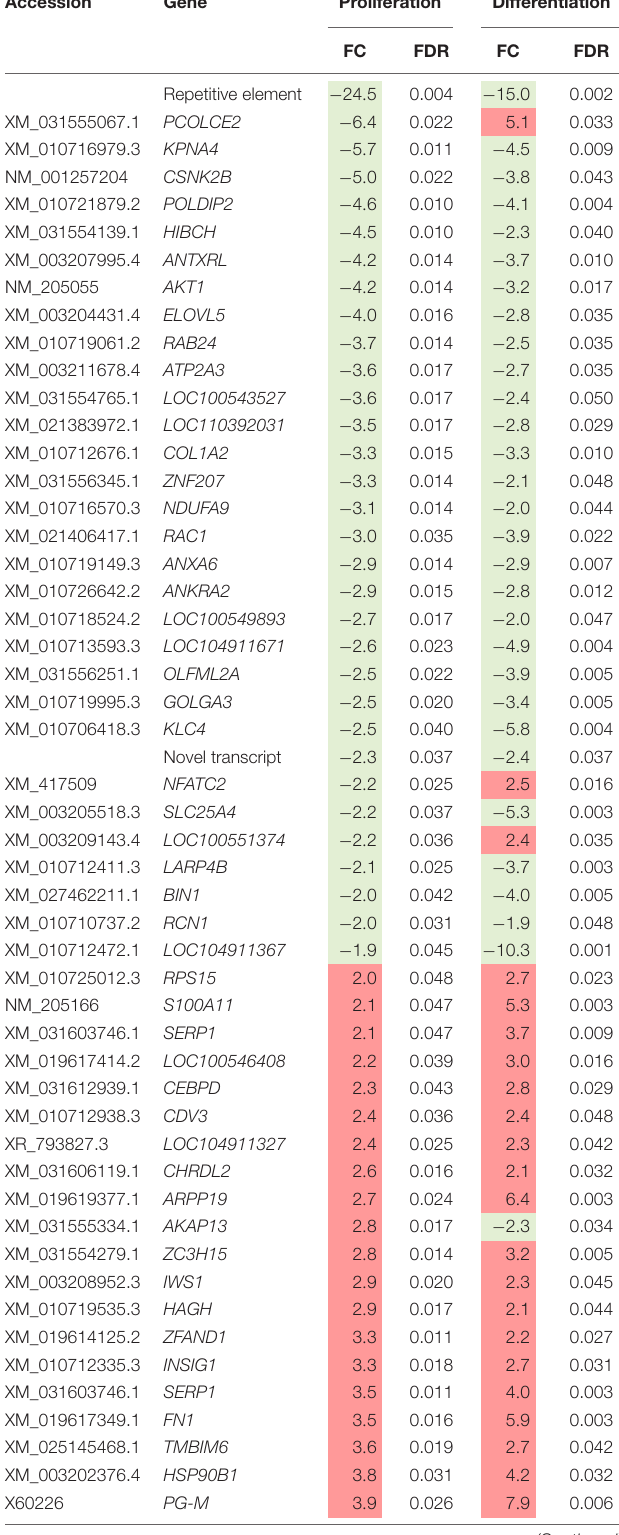
TABLE 1 | Differentially expressed transcripts identified in both proliferation and differentiation knockdown